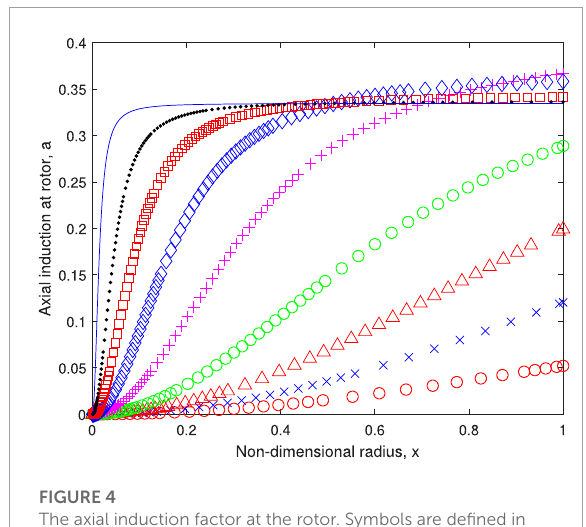
FIGURE 3 Optimal actuator disc power and thrust. × is C P from Glauert (1935). The circles are C P , the diamonds are C T from Table 1 . The solid line is for visual aid only. Note that C P asymptotes to the BJ limit of 16 / 27 and C T to the corresponding limit of 8 / 9.